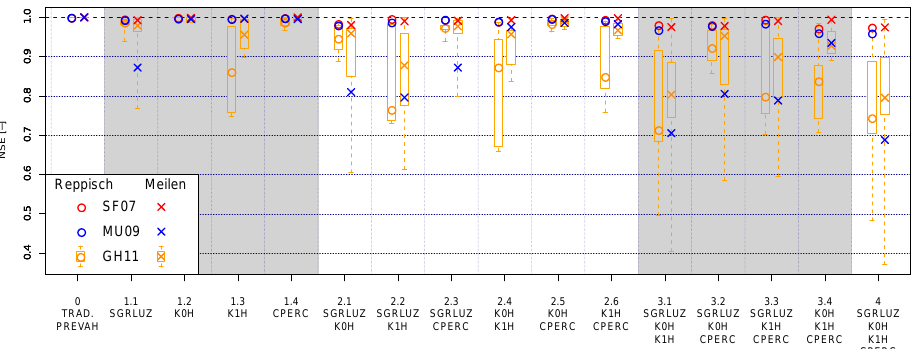
Figure 11. Modified NSE obtained by comparing the runoff simulated with the automatic DRP maps with that simulated with the reference maps, in the two study sites (simulation period 16 June 2014–15 August 2014). The boxplots show the medians and the interquartile ranges of the simulations driven by GH11 maps, while the labels on the abscissa show the model parameters whose values were defined based on the